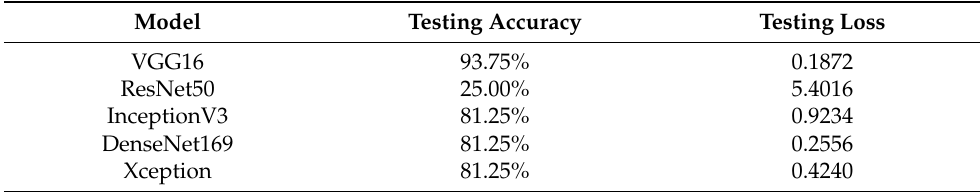
Table 6. Testing accuracies and loss when SLIC segmentation was used to create superpixels with a compactness (m) value of